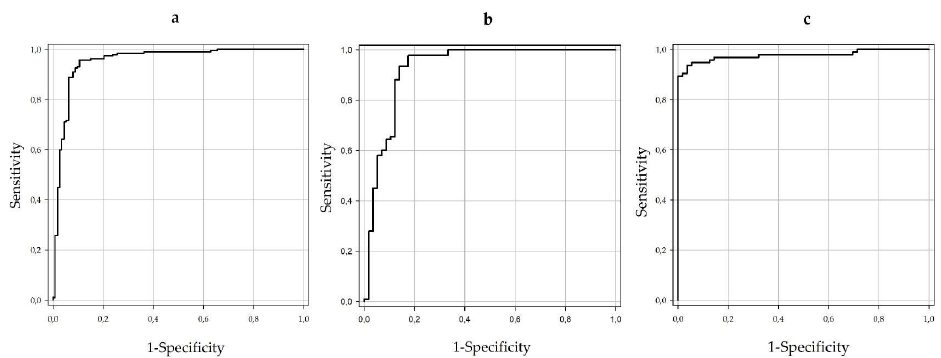
Figure A1. Comparative ROC analyses: Graph ( a ) shows the ROC curve for all 300 serum samples, graph ( b ) the 150 CCHFV seronegative samples and graph ( c ) the 150 CCHFV seropositive samples only. Table A1. Detailed version of Table 4 in the main section. Diagnostic Assay